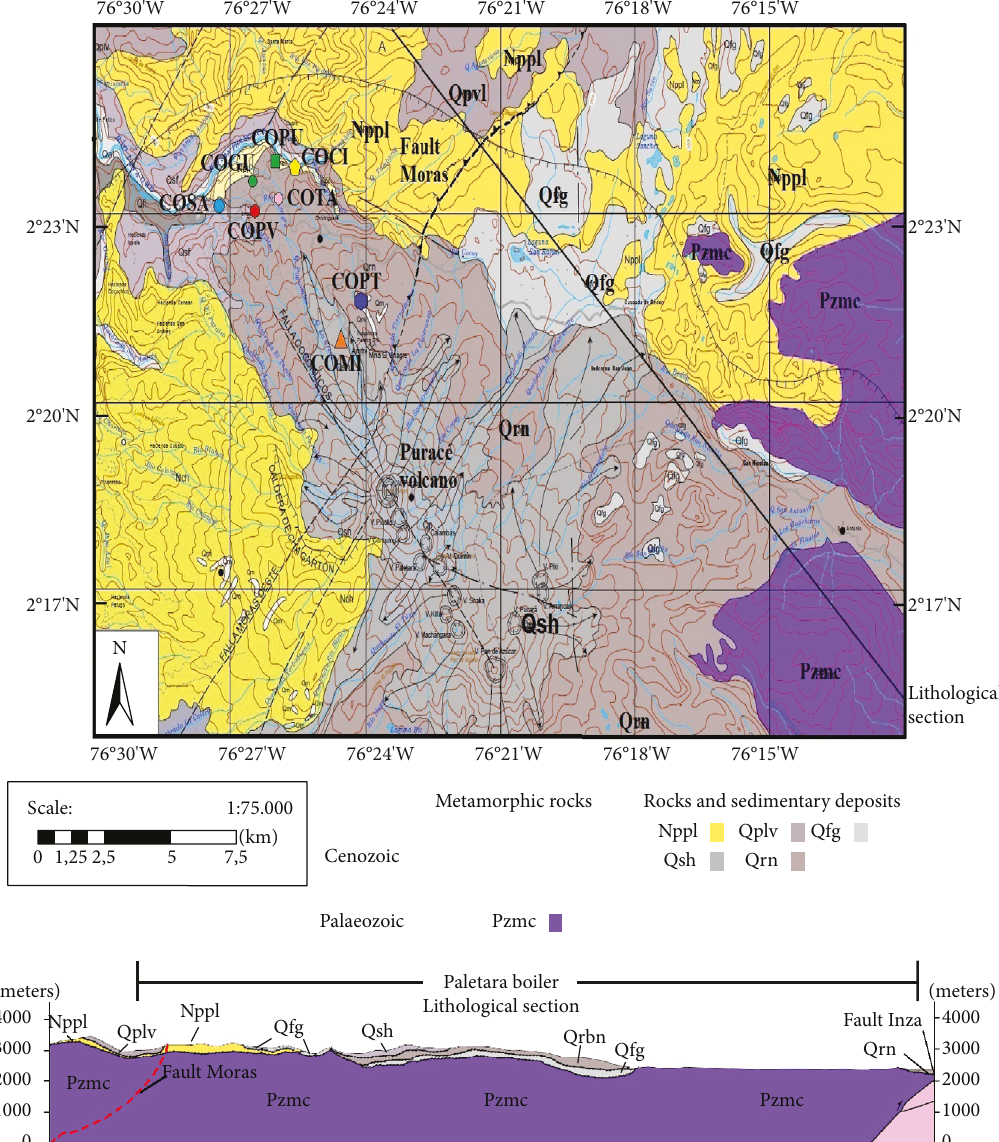
Figure 2: Location of the monitoring sites of the Puracé-La Mina sector and lithological section. Map of the Servicio Geológico Colombiano [55]. Nppl (lavas of andesitic compositions), Qplv (ash fl ow reservoirs), Qfg ( fl uvioglacial deposits), Qsh (andesitic lava), Qrn (andesitic lava) (Batolito Ibagué), and Pzmc (green and black shales).